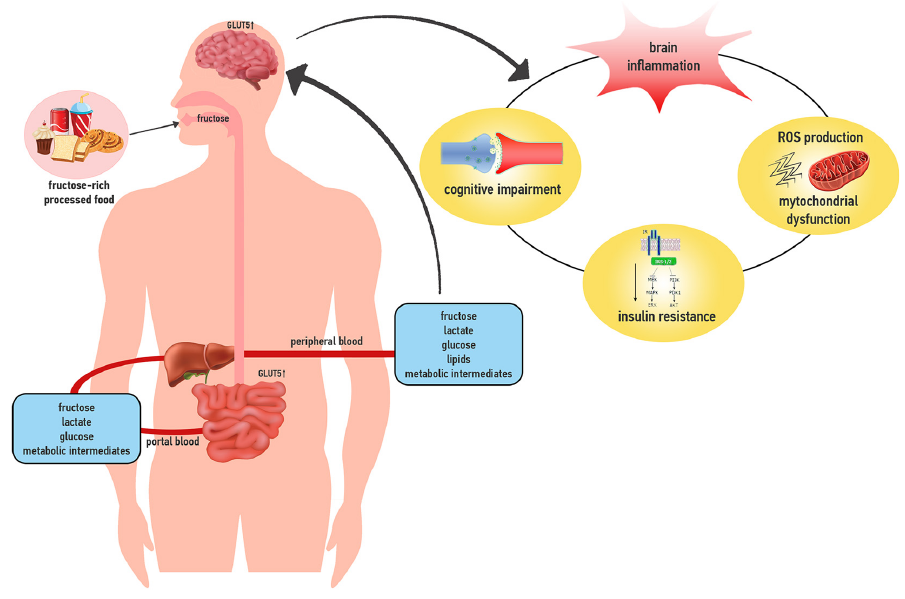
Figure 1. Fructose is cleared by the small intestine, which converts it into different metabolic intermediates. High fructose doses overwhelm the intestinal capacity for fructose metabolism, and a part of fructose spills over to the liver, which can metabolize it. Gut- and liver-derived metabolic intermediates or fructose itself can reach the brain, exerting effects on regulation of food intake, brain inflammation, mitochondrial function and oxidative stress, insulin signaling and cognitive function. Down arrow indicates downregulated and up arrow indicates upregulated cellular pathways by fructose intake. GLUT5 = glucose transported